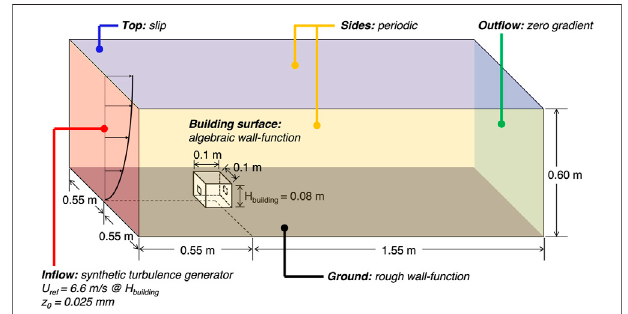
FIGURE 1 | Computational domain and boundary conditions for the large-eddy